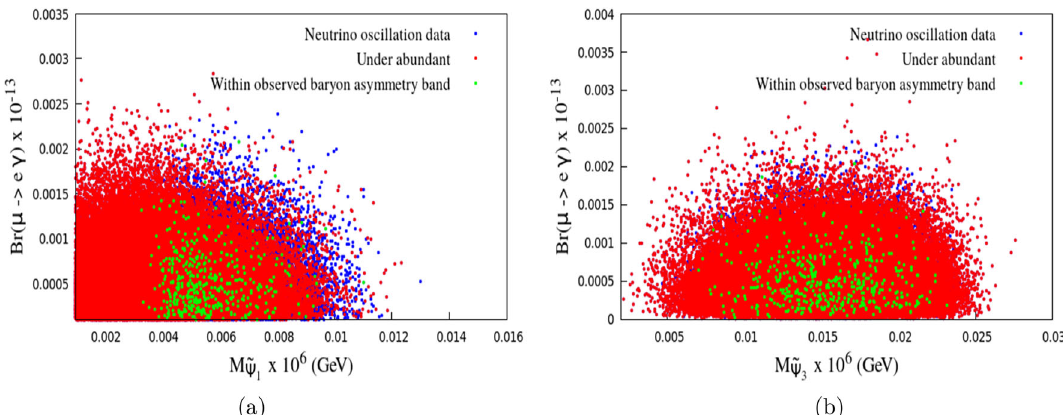
Fig. 2 Branching ratios of radiative decay of muon ( μ → e γ ) with the mass of the heavy neutrinos ( a M ˜ (cid:9) in legends